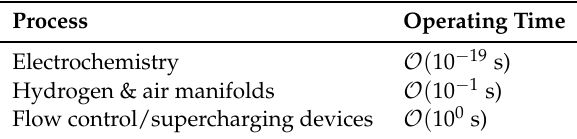
Figure 3. Linear quadratic regulator (LQR) design for m O Table 4. Fuel cell system operating time requirements.